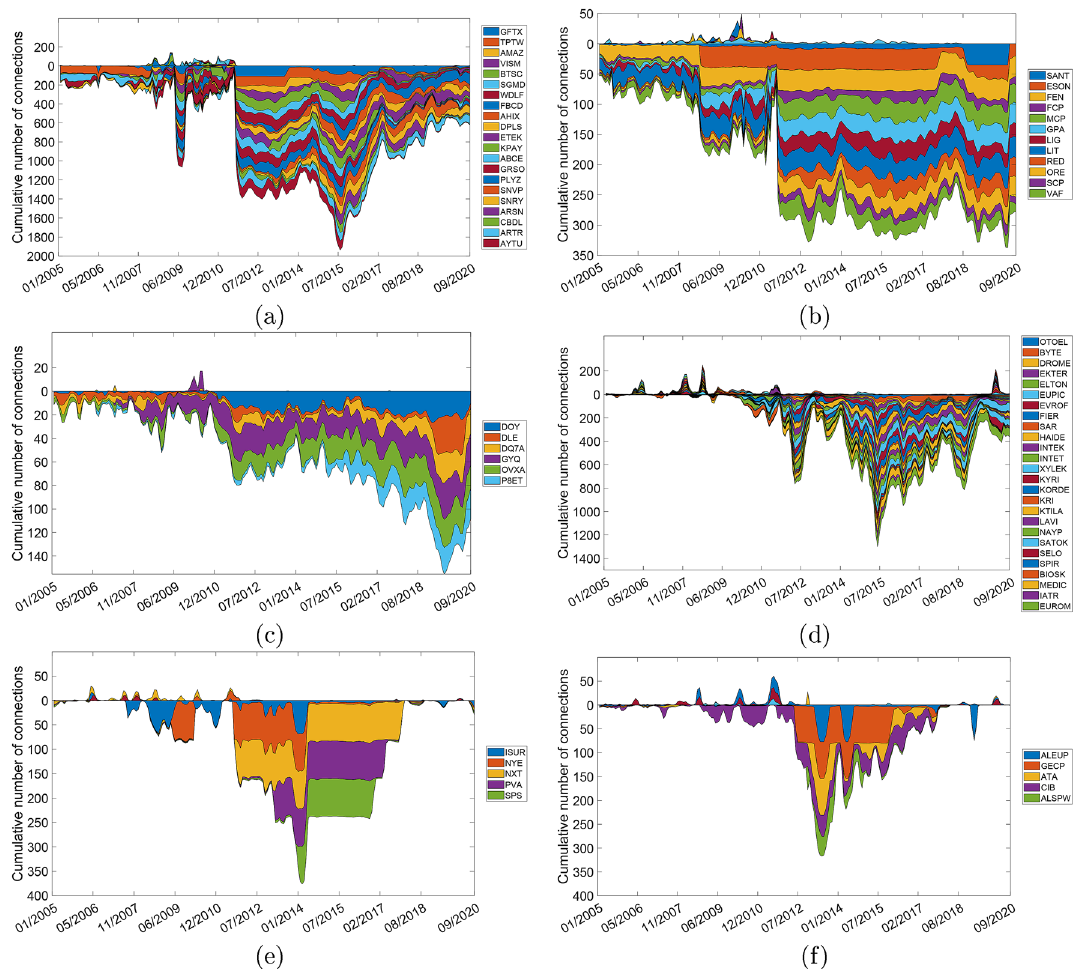
Figure 4. Positive and negative cumulative centrality degrees. ( a ) The US. ( b ) Portugal. ( c ) Ireland. ( d ) Greece. ( e ) Spain. ( f ) France. Temporal evolution of the cumulative number of connections (degrees) of every stock in the FNC of the six countries where BUT occurred. The cumulative number of positive connections with other stocks are shown over the horizontal line, and the cumulative number of negative connections are shown below that